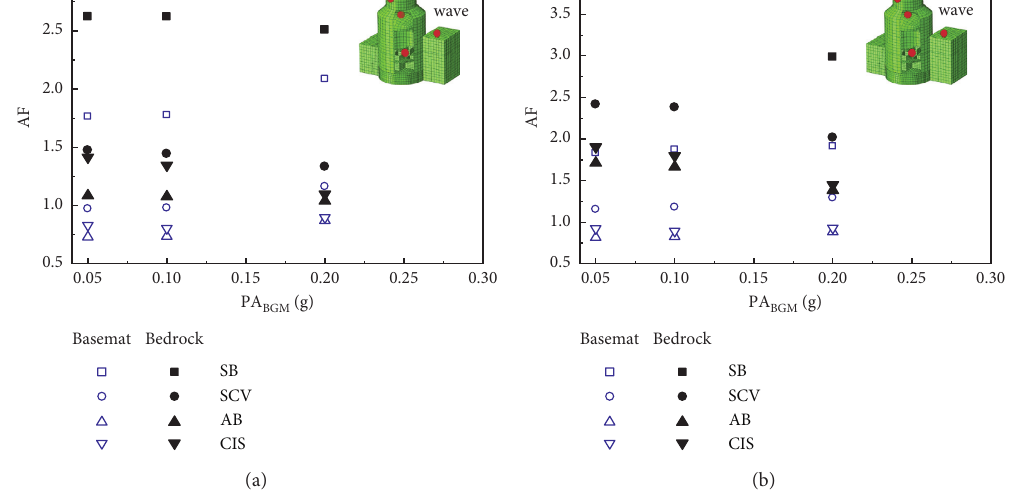
Figure 10: AF of the PFA of the nuclear island structure.